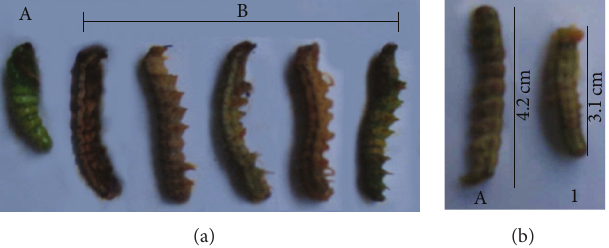
Figure 5: (a) Development of H. armigera fed on diets with and without BmPI. (A) Larvae fed on control diet show normal growth and pupation. (B) Larvae fed on test diet-containing BmPI did not undergo pupation and died. (b) Variations in the size (centimetres) of fourth instar H. armigera larvae fed on 0.1% w/w BmPI (1) and control (A)